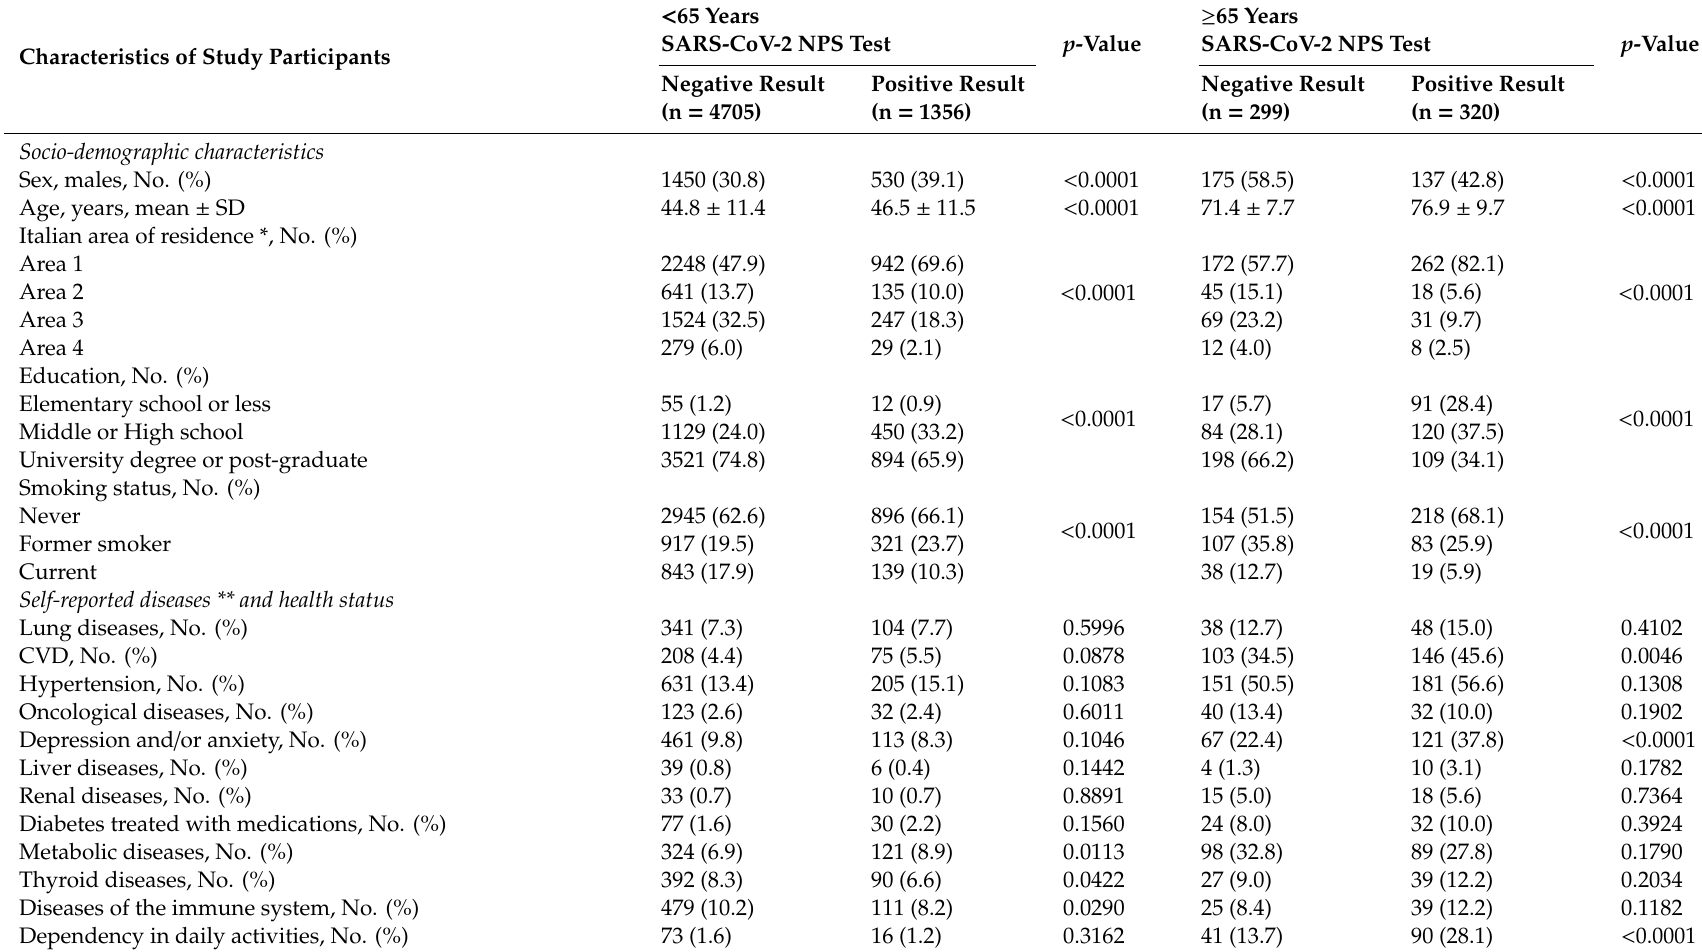
Table 2. Characteristics of study participants with an available SARS-CoV-2 NPS test